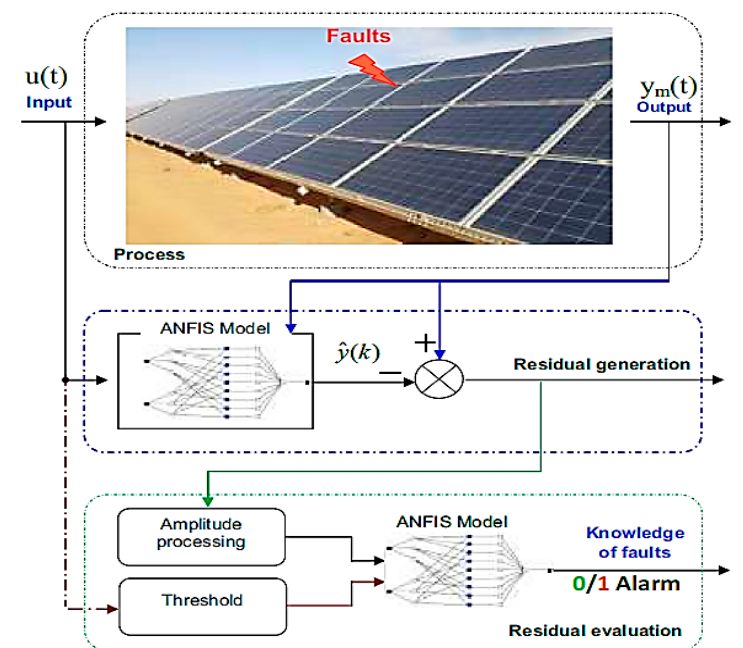
Figure 1. Structure of the method presented to model the behavior of the panel in different weather conditions [21].